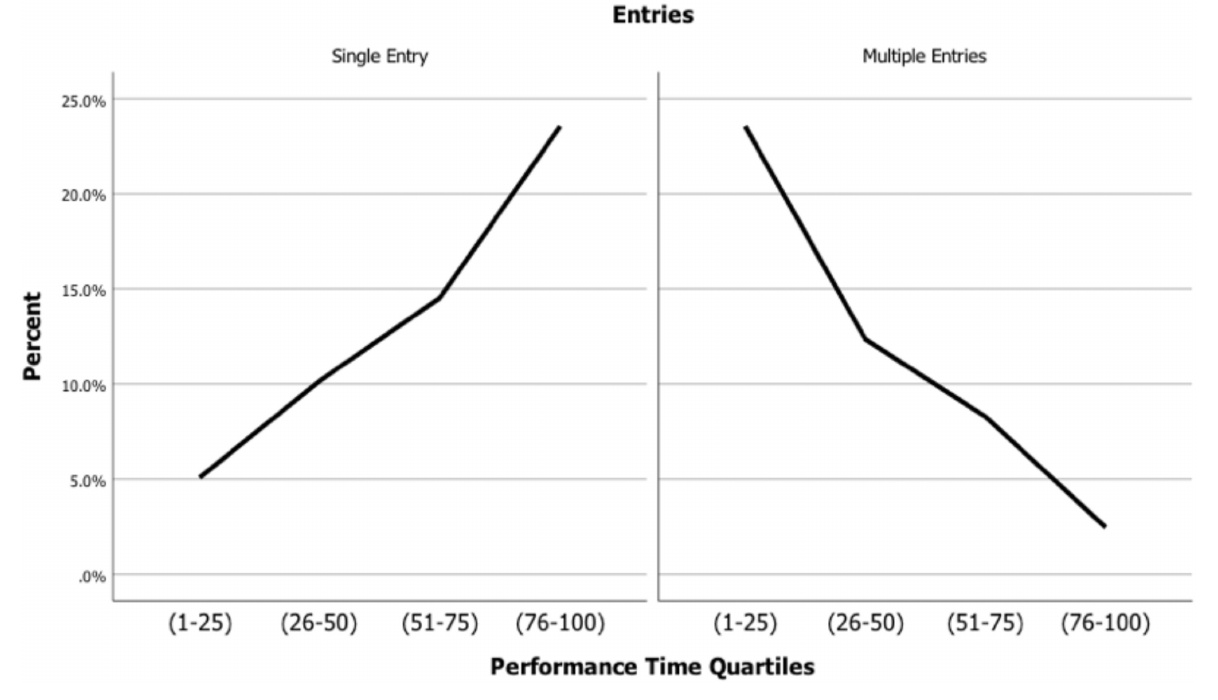
FIGURE 1 | Percent single and multiple data entries by performance